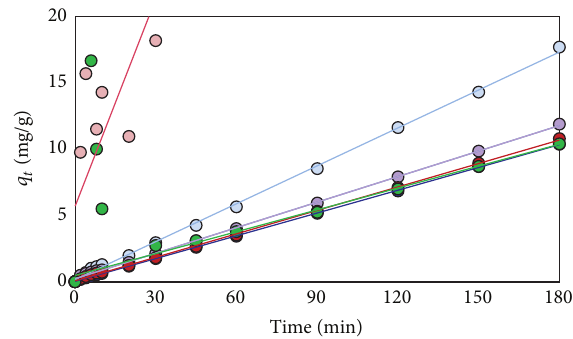
Figure 9: Plot of Cr 3+ adsorption capacity at time ( 𝑞 𝑡 ) and % removal versus adsorption time for effect of various sorbents (RS (light blue), RS-oil 3 hr (purple), RS-NaOH 450 W (blue), Bagasse (pink), Bagasse-NaOH 600 W (red), and Dowax (green)).